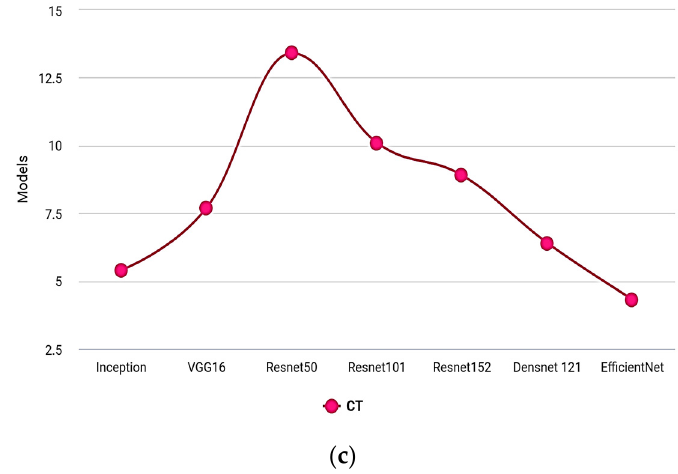
Figure 9. Models vs. ( a ) IoU, ( b ) mAP, ( c ) CT. Table 7. Comparison analysis of the proposed model under IoU, mAP, and CT.